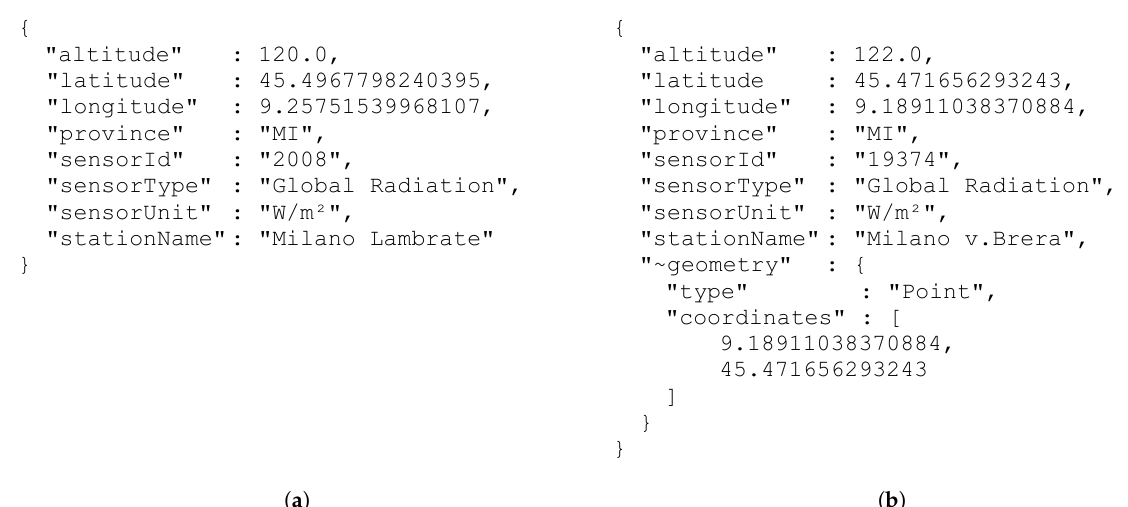
Figure 5. Example of a document in the temporary collection generated by line 4 ( a ) and by line 5 ( b ). ( a ) Example of a document describing a weather sensor, without geometry. ( b ) Example of a document describing a weather sensor with